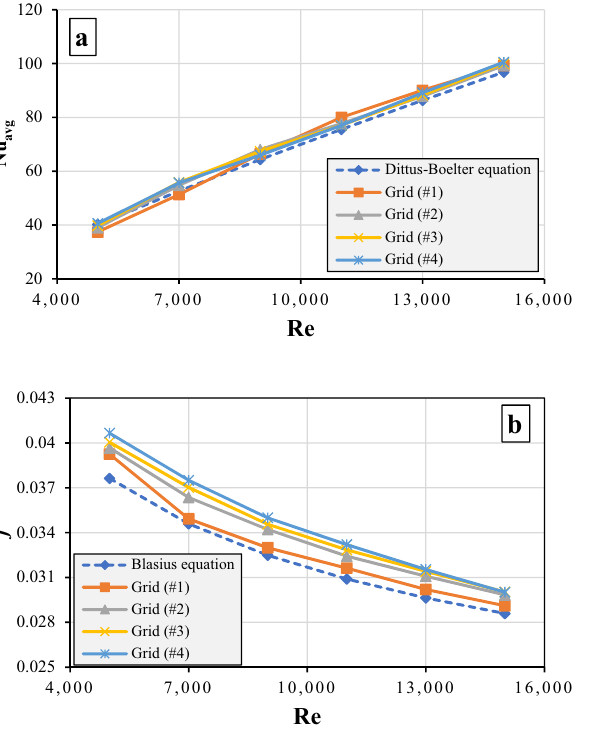
Figure 2: Grid independence results between simulation and empirical correlations for DW: ( a ) average Nusselt number and ( b ) friction factor.